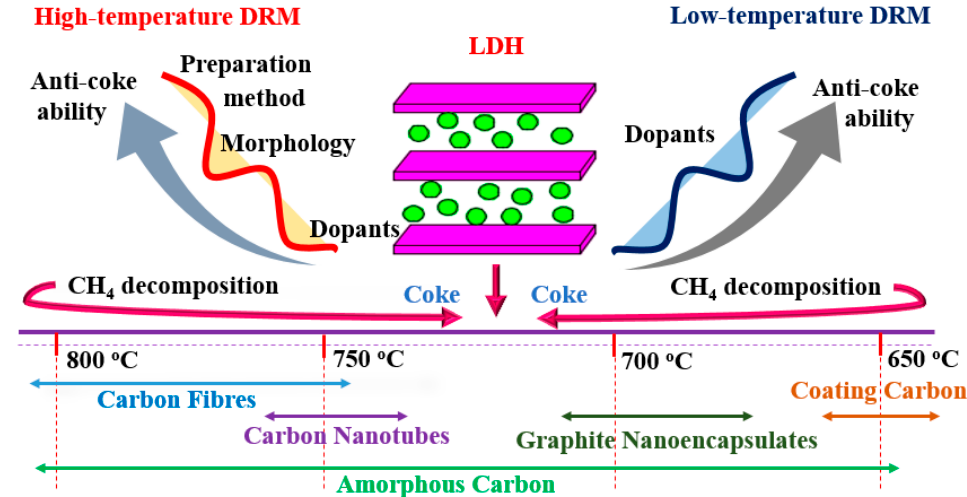
Figure 4. The application of LDHs in dry reforming of methane. DRM, dry reforming of methane.